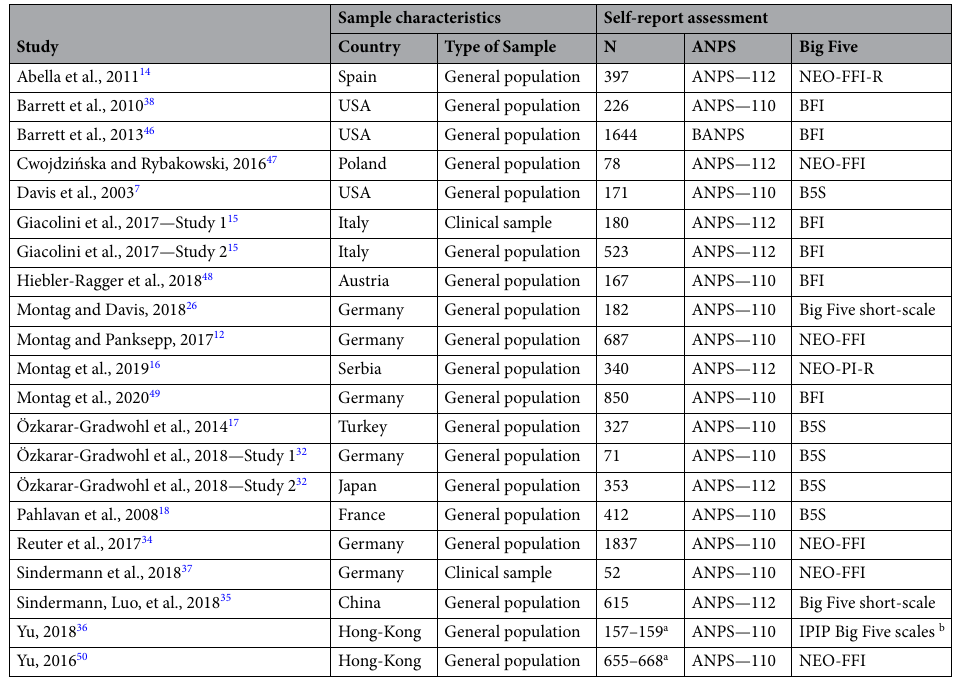
Table 1. Characteristics of studies included in the meta-analysis. ANPS Affective Neuroscience Personality Scales, BANPS Brief Affective Neuroscience Personality Scales, B5S Big Five Scales, BFI Big Five Inventory, NEO-FFI NEO Five-Factor Inventory, NEO Five-Factor Inventory-R NEO Five-Factor Inventory-Revised. a In these studies, sample size varied based on the specific combination of ANPS and Big Five scales examined. b Only the Agreeableness and Conscientiousness traits were assessed in the